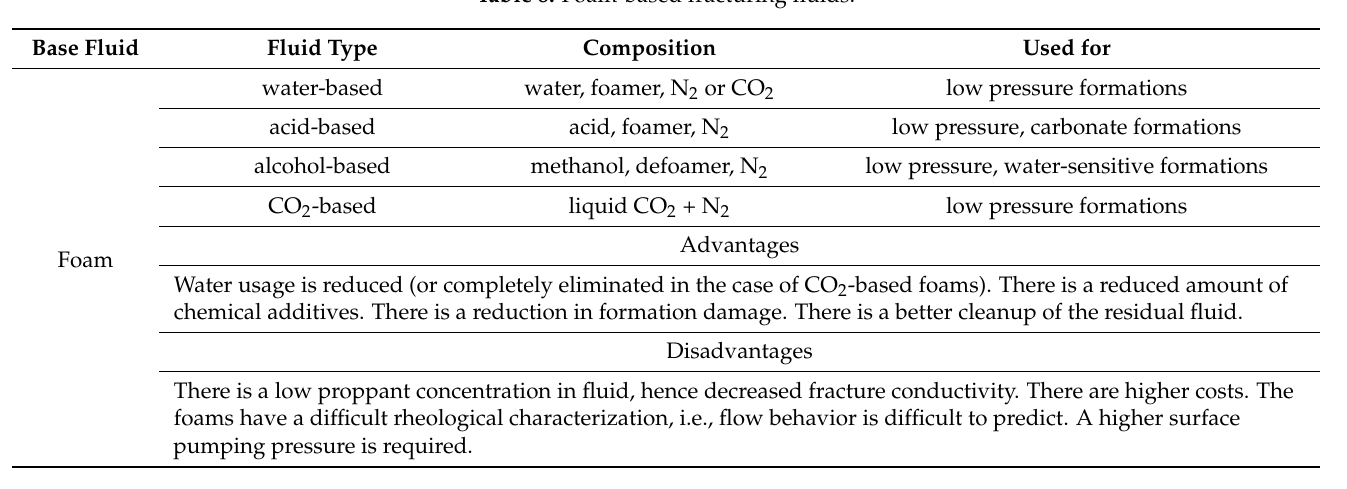
Table 8. Foam-based fracturing